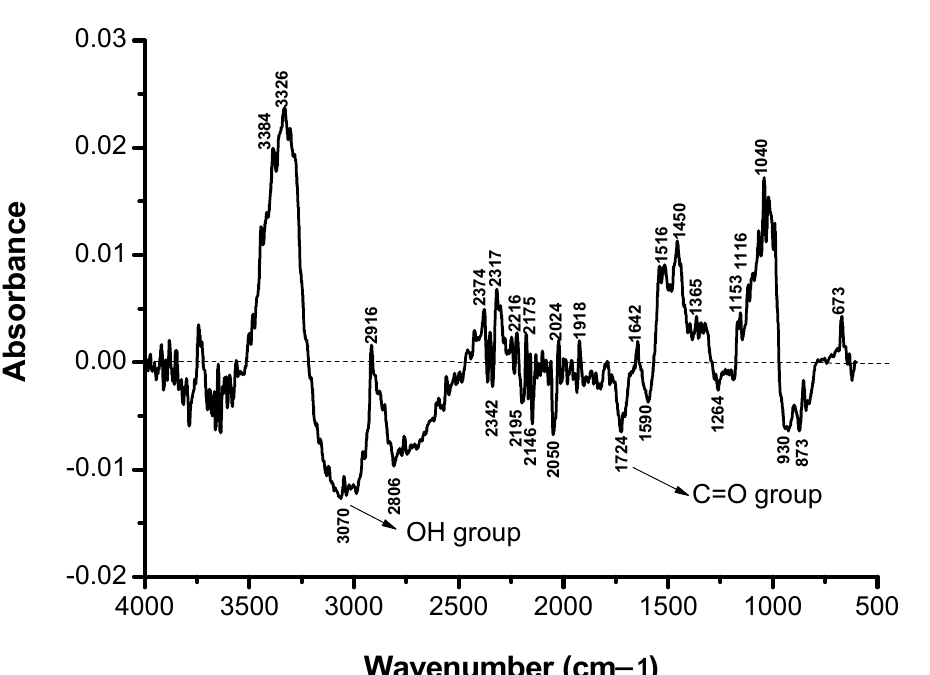
Figure 10. FTIR spectra of: ( a ) initial RB_204 dyed cotton fabric; ( b ) RB_204 dyed cotton fabric ir- radiated at 25 h; at ( c ) 50 h; at ( d ) 75 h, and at ( e ) 100 h; ( f ) cotton fabric.